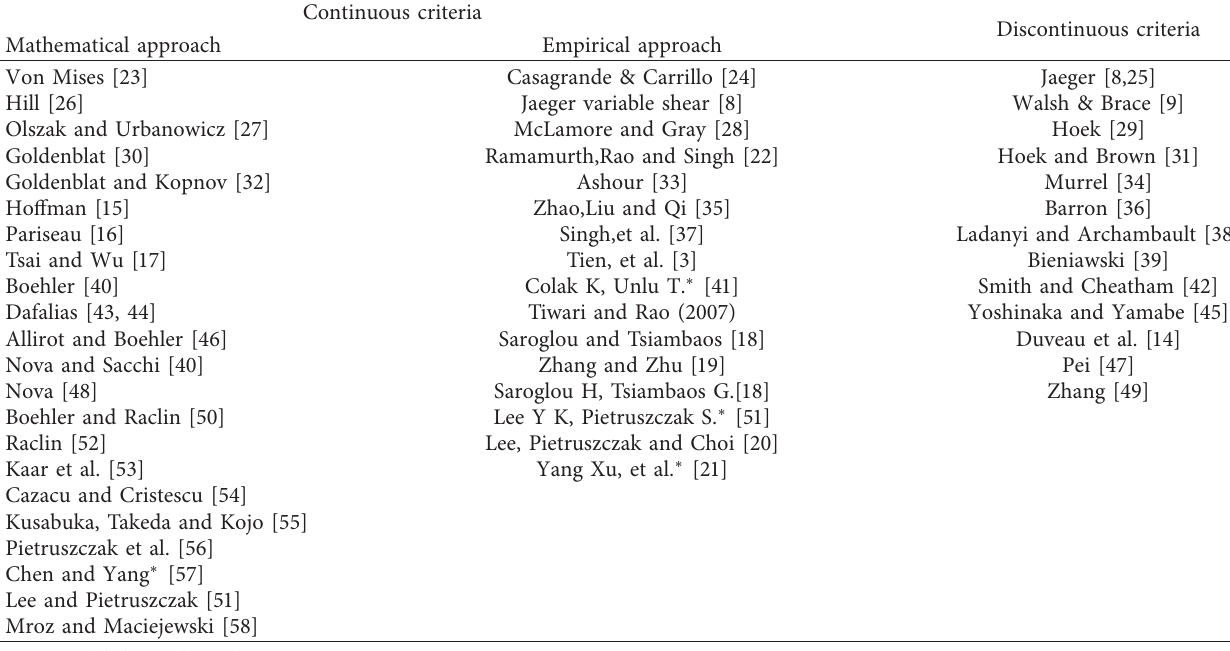
Table 1: Classification of anisotropic failure